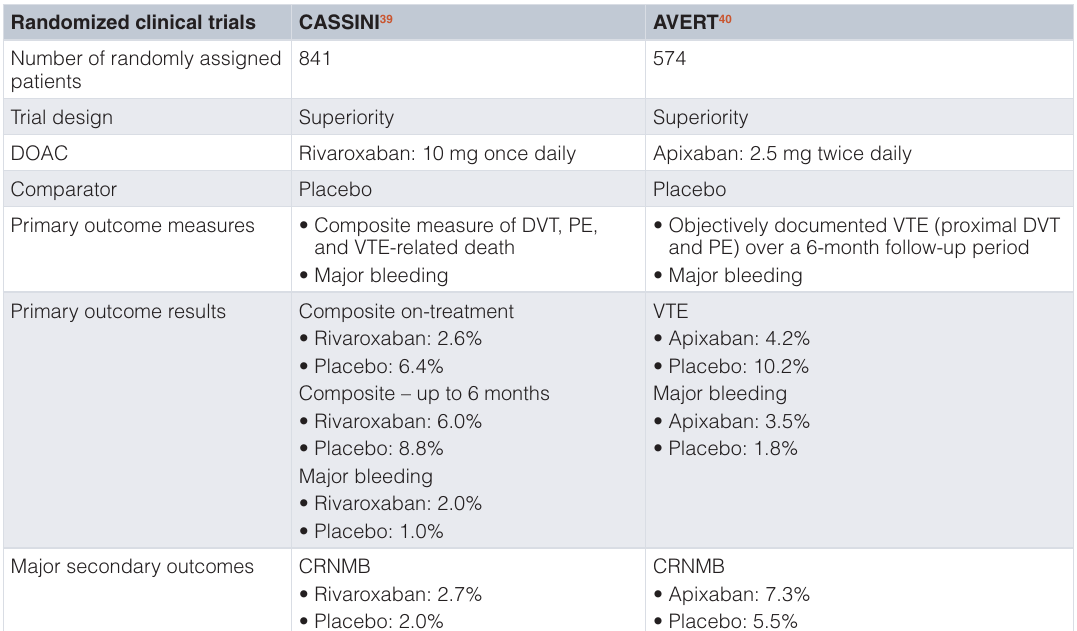
Table 2. Randomized clinical trials assessing the efficacy and safety of direct oral anticoagulants in the prophylaxis of cancer-associated thrombosis. Randomized clinical